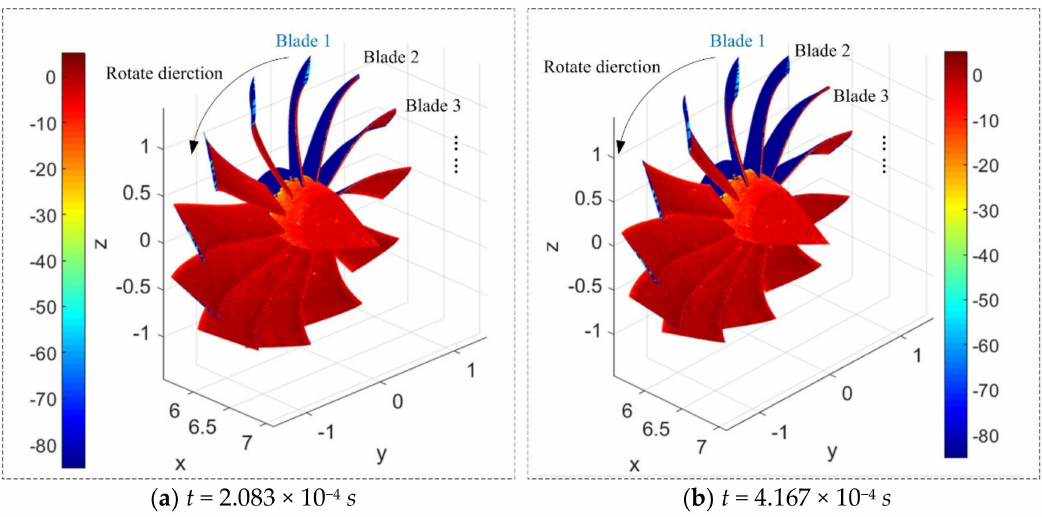
Figure 6. Surface scattering distribution of the fan, α = 0 ◦ , β = 0 ◦ , and f R = 6 GHz; RCS unit: dBm 2